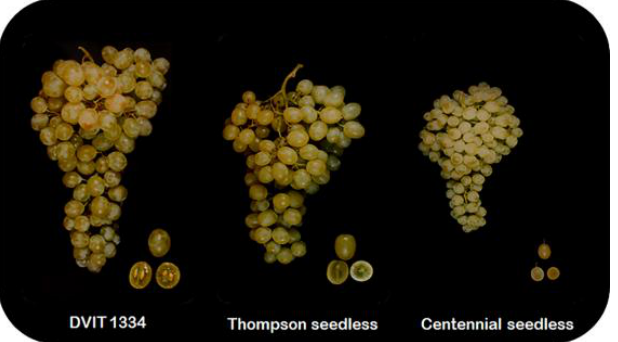
Figure 1. Close-up cluster views of Thompson seeded mutant (DVIT 1334), Thompson seedless, and Centennial seedless grape genotypes exhibiting seeded, stenospermocarpy, and parthenocarpy fruit set programs, respectively.